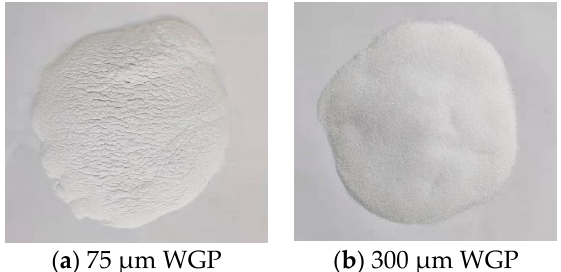
Figure 1. The features of WGP of different granularity: ( a ) 75 μ m; ( b ) 300 μ m.